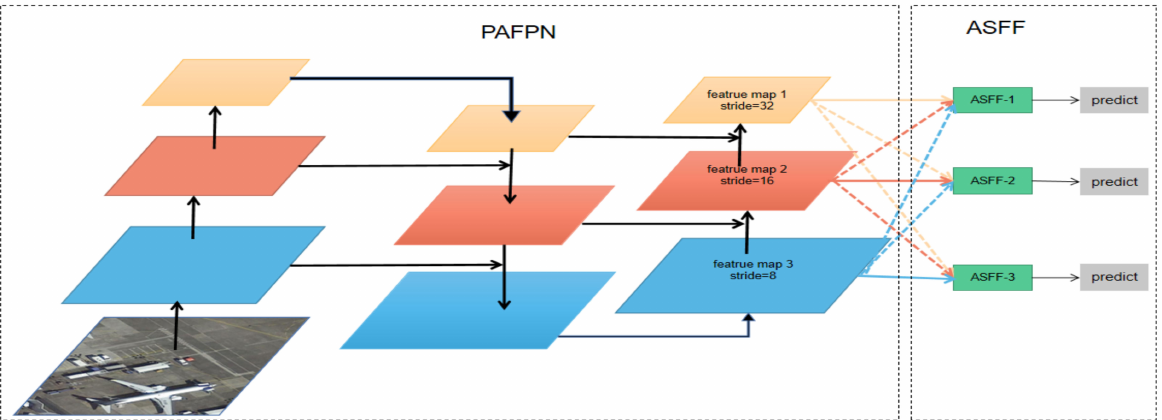
Figure 6. Structure of PAFPN and